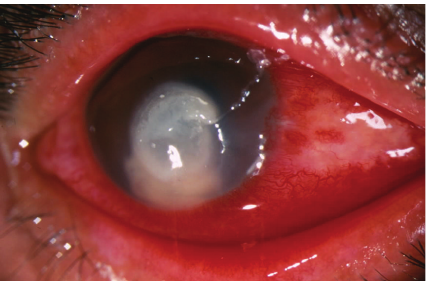
Figure 4: Fungal keratitis caused by Aspergillus fumigatus .